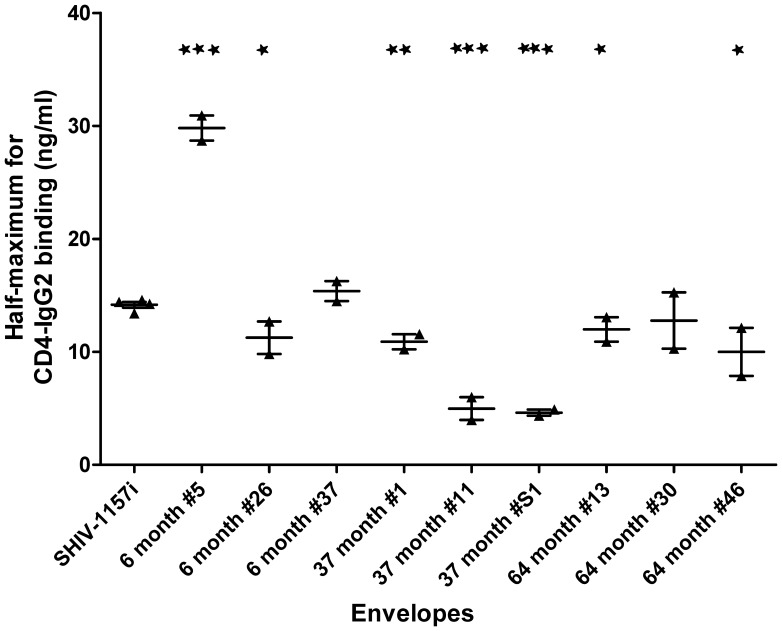
Envelope binding to CD4 and virus fusion with target cells.Purified viruses, expressing selected V1-V5 regions from each time point, were tested with in-vitro CD4 binding assay to determine their half maximum binding to CD4-IgG2. Each symbol for individual envelope clones represents an independent experiment. “*” represent statistical significant compare to the inoculum, SHIV-1157i. The value of 6 month #5 may not reflect the actual data since it falls beyond the maximum range of our assay.